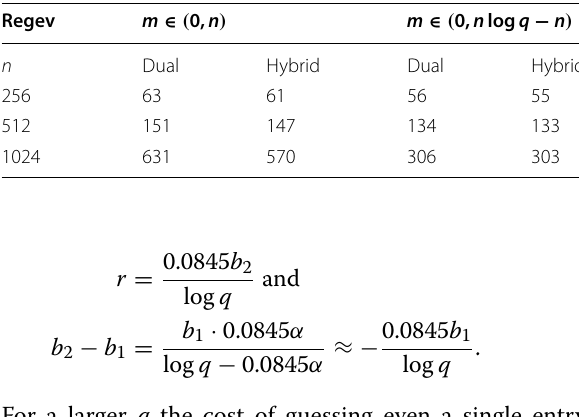
Table 4 (Hybrid) embedded dual